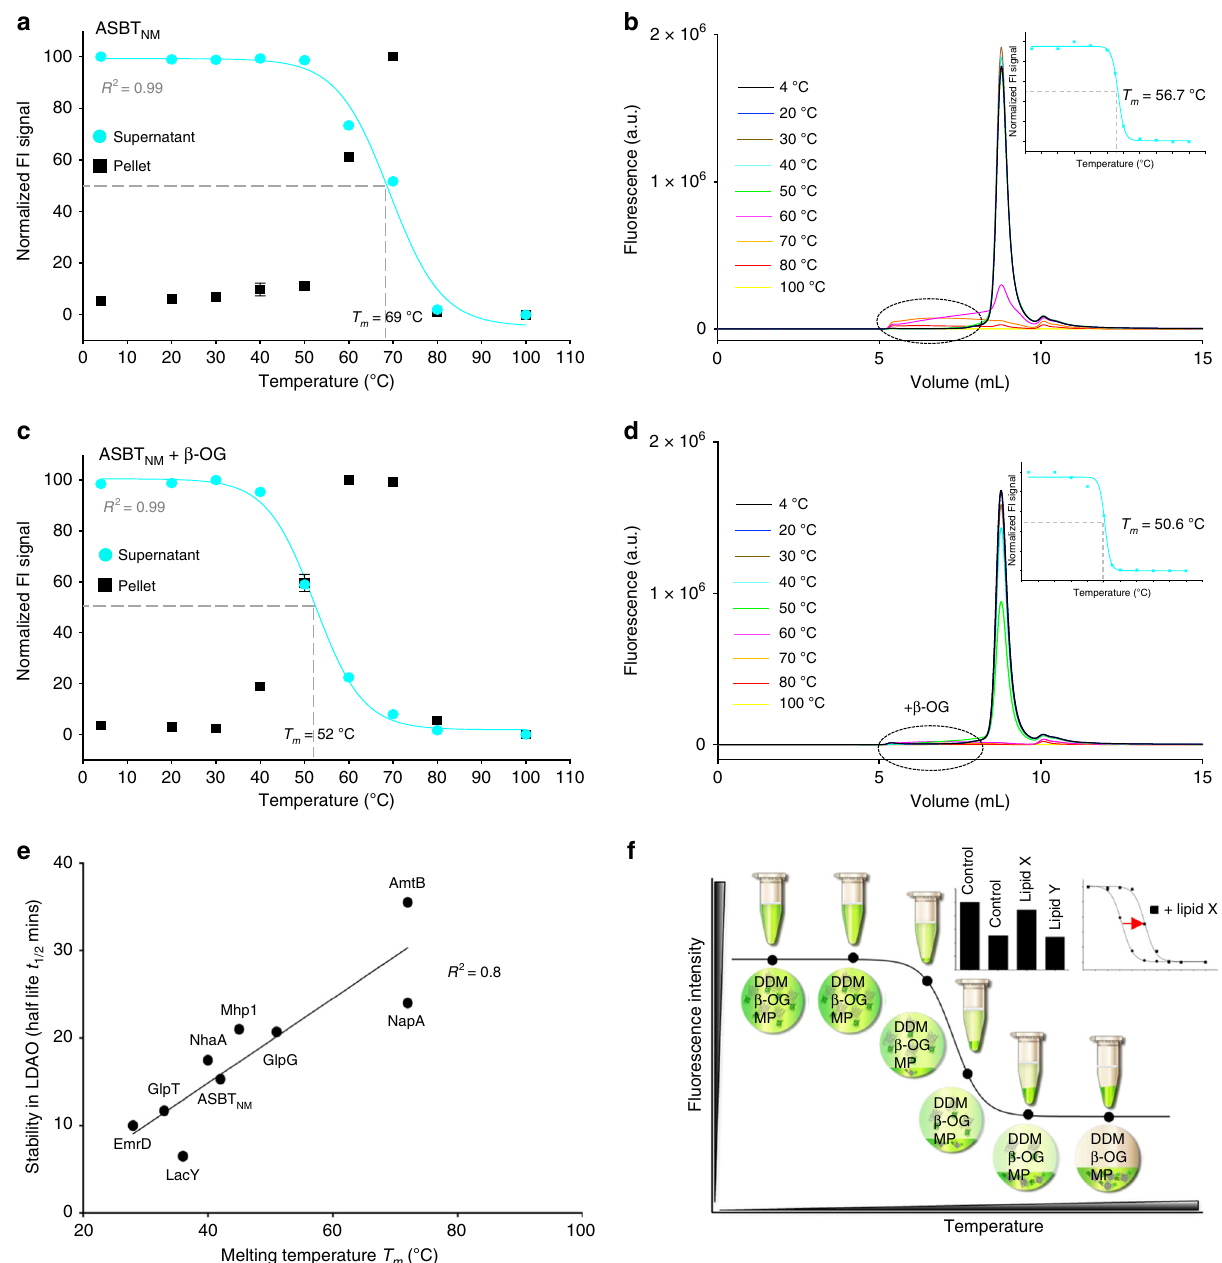
Fig. 2 Developing GFP-TS for high-throughput lipid screening. a Total fl uorescence, measured on a 96-well microplate spectro fl uorometer, from DDM- solubilized ASBT NM -GFP membranes remaining in solution after heating and centrifugation (cyan circles). Fluorescence from pellets resuspended in the same volume of buffer as the supernatant (black squares). Apparent T m were calculated using a range of nine different temperatures that were fi tted to a sigmoidal dose – response equation as described in Methods (bars show the range of two technical replicates, and the values reported are the mean ± s.e.m. of the fi t). b . FSEC-TS traces of the ASBT NM -GFP supernatants measured in a with a plate reader; the aggregates are highlighted by a dotted circle and the corresponding FSEC-TS melting curve as an inset c . As in a except after the addition of the detergent β -OG to the DDM-solubilized ASBT NM -GFP samples; error bars show the range of two technical replicates and the values reported for the apparent T m are the mean ± s.e.m. of the fi t, which were further combined with a separate titration and are tabulated in Table 1. d FSEC-TS traces of the ASBT NM -GFP supernatants measured in c with a plate reader; the location of the aggregates removed by β -OG are highlighted by a dotted circle and the corresponding FSEC-TS melting curve as an inset. e Correlation between the thermostability assessed by the direct CPM assay on DDM-puri fi ed fusions in the detergent LDAO 21 versus the indirect GFP-TS assay on unpuri fi ed fusions in the detergents DDM and β -OG; the transporters listed are also described in Table 1. f Schematic representation of the GFP-TS